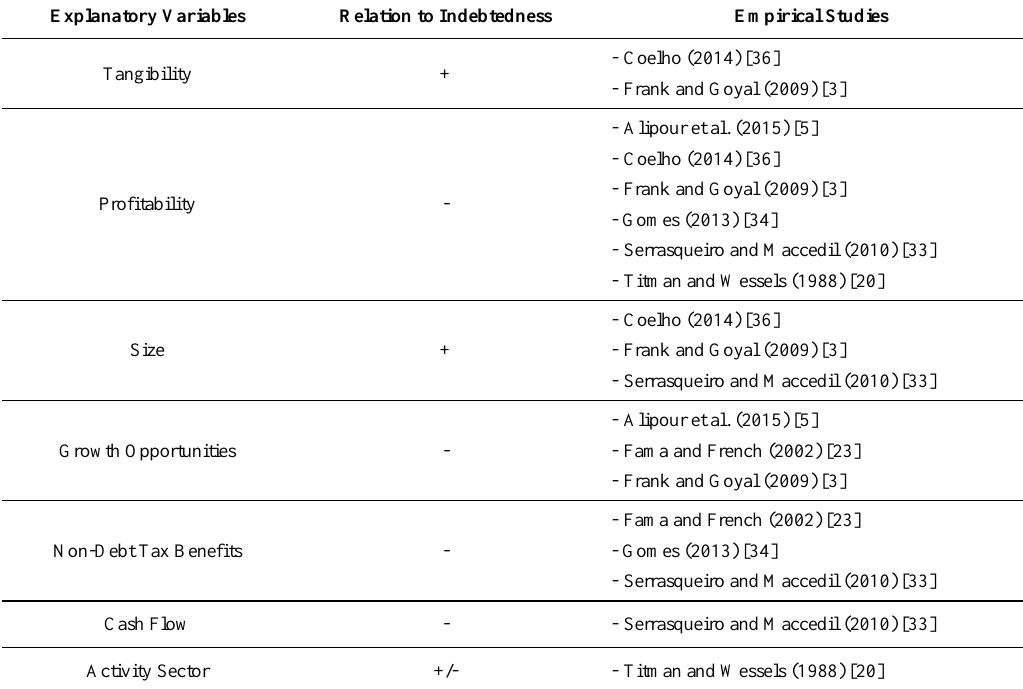
Table 3. Empirical evidence of the relationship between indebtedness and determinants of capital